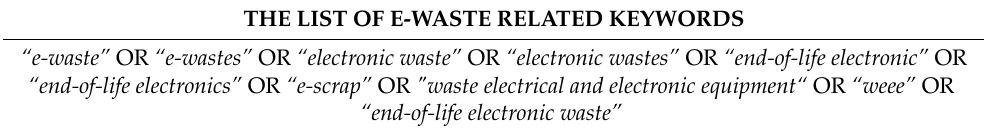
Table 2. The list of keywords searched in ProQuest Dissertation and Thesis database. THE LIST OF E-WASTE RELATED